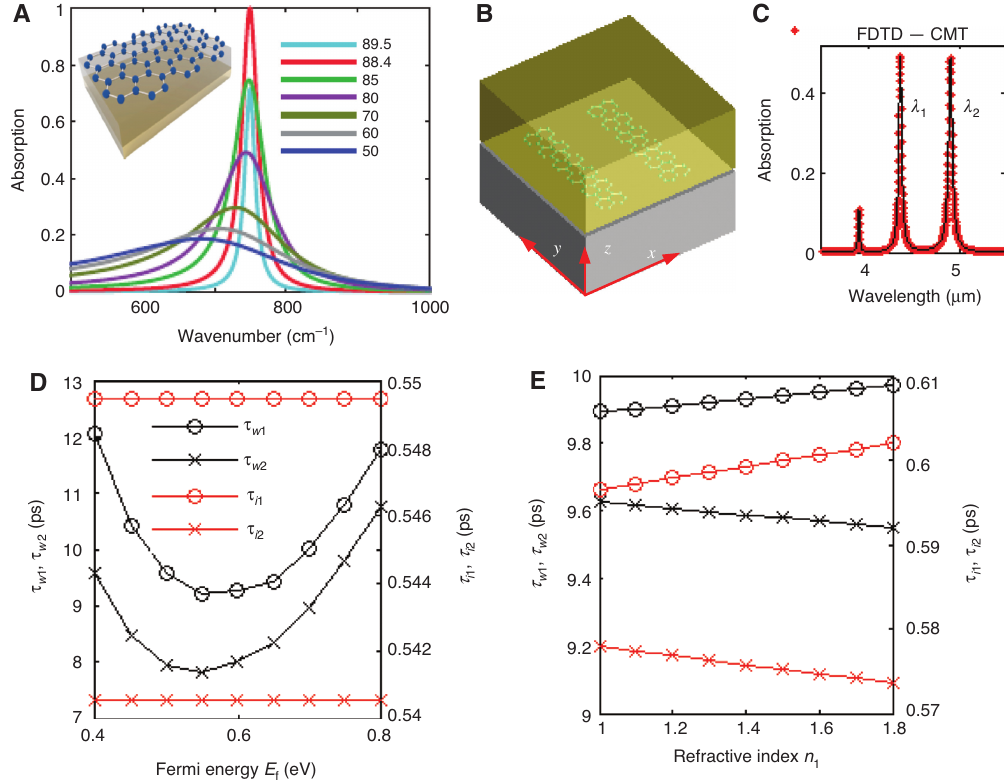
Figure 1: Angle-selective, grating-selective absorption and their lifetime in graphene structure. (A) The angle-selective absorption and the planar graphene structure [132]. (B) The nanostructured DGN surrounded with substrate and superstrate such as aqueous solution. (C) The simulated linear-optical absorption with FDTD simulation (black circles) and the theoretical CMT analysis results (red line). τ